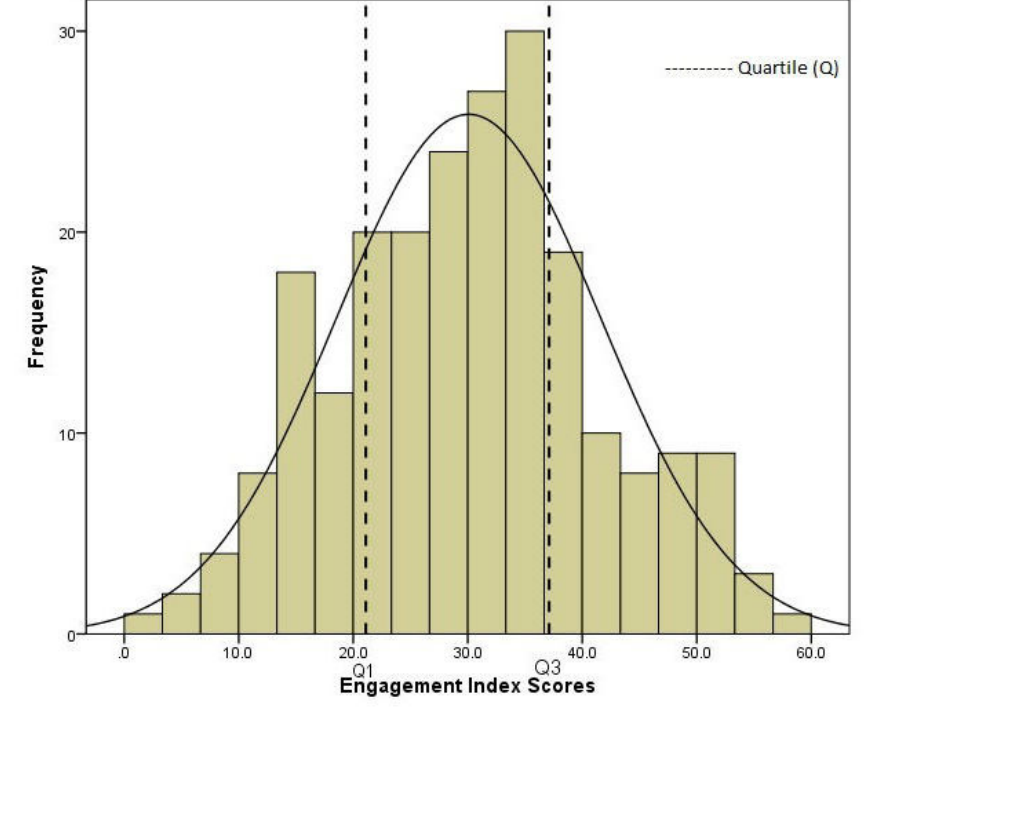
Figure 2. Overall engagement index scores